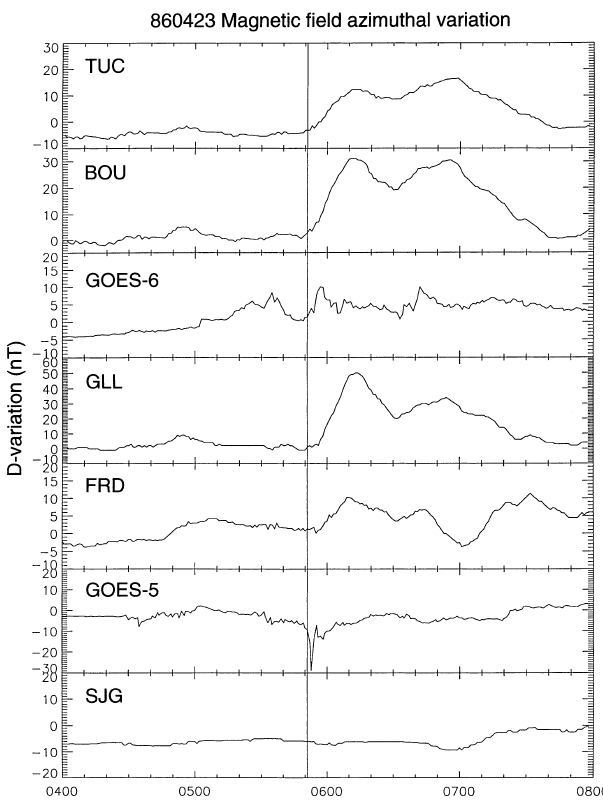
Fig. 2. The D-variation (in nT) from low-latitude stations and from GOES satellites, on April 23, 1986. Tucson is the most westward point of our longitudinal chain, while San Juan is the most eastward point. The vertical line corresponds to the